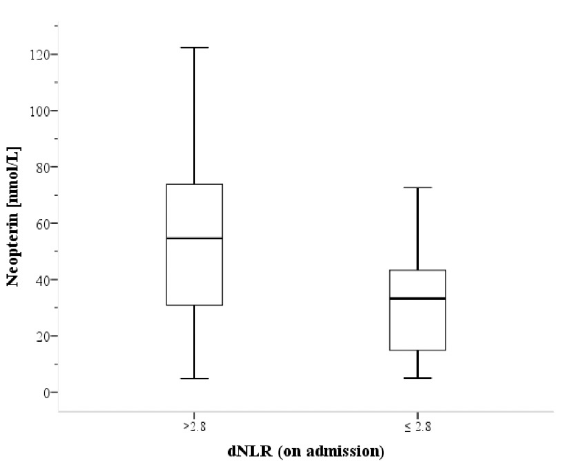
Figure 2 : Comparison of serum neopterin concentrations according to derived neutrophil/lymphocyte ratio (dNLR) (>2.8 and ≤ 2.8) on admission. The upper and lower portions of the boxes indicate the 25 th and 75 th percentiles, respectively. Horizontal lines within the boxes indicate the 50 th percentile (median). p < 0.05 differences between the